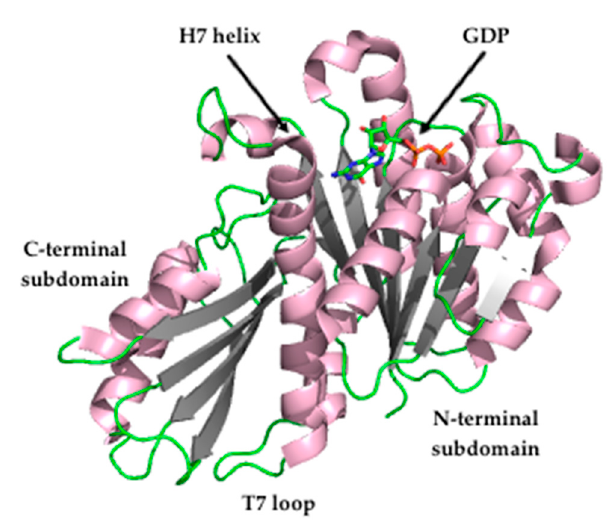
Figure 2. Crystal structure of Staphylococcus aureus FtsZ (PDB entry 3VO8) [27].